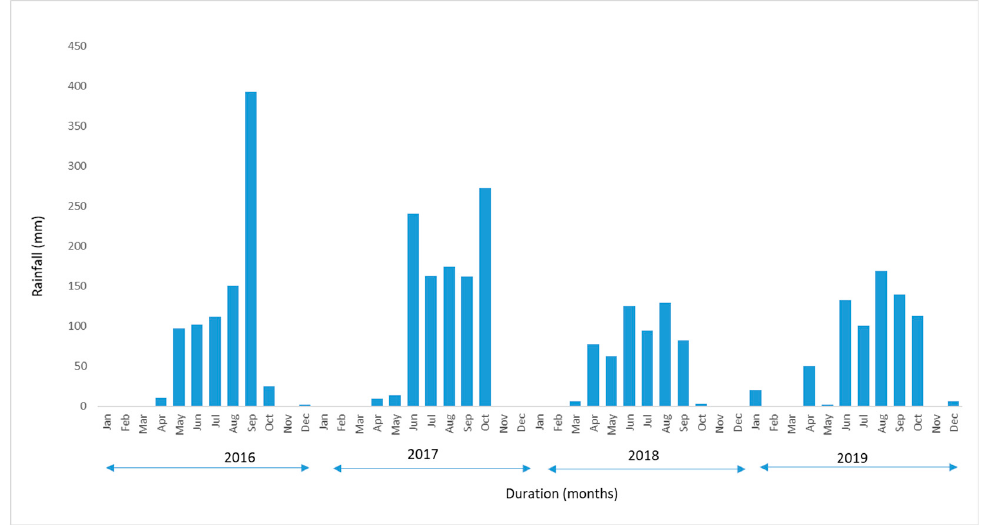
Figure 1. Rainfall distribution during the study period (2016 to 2019).